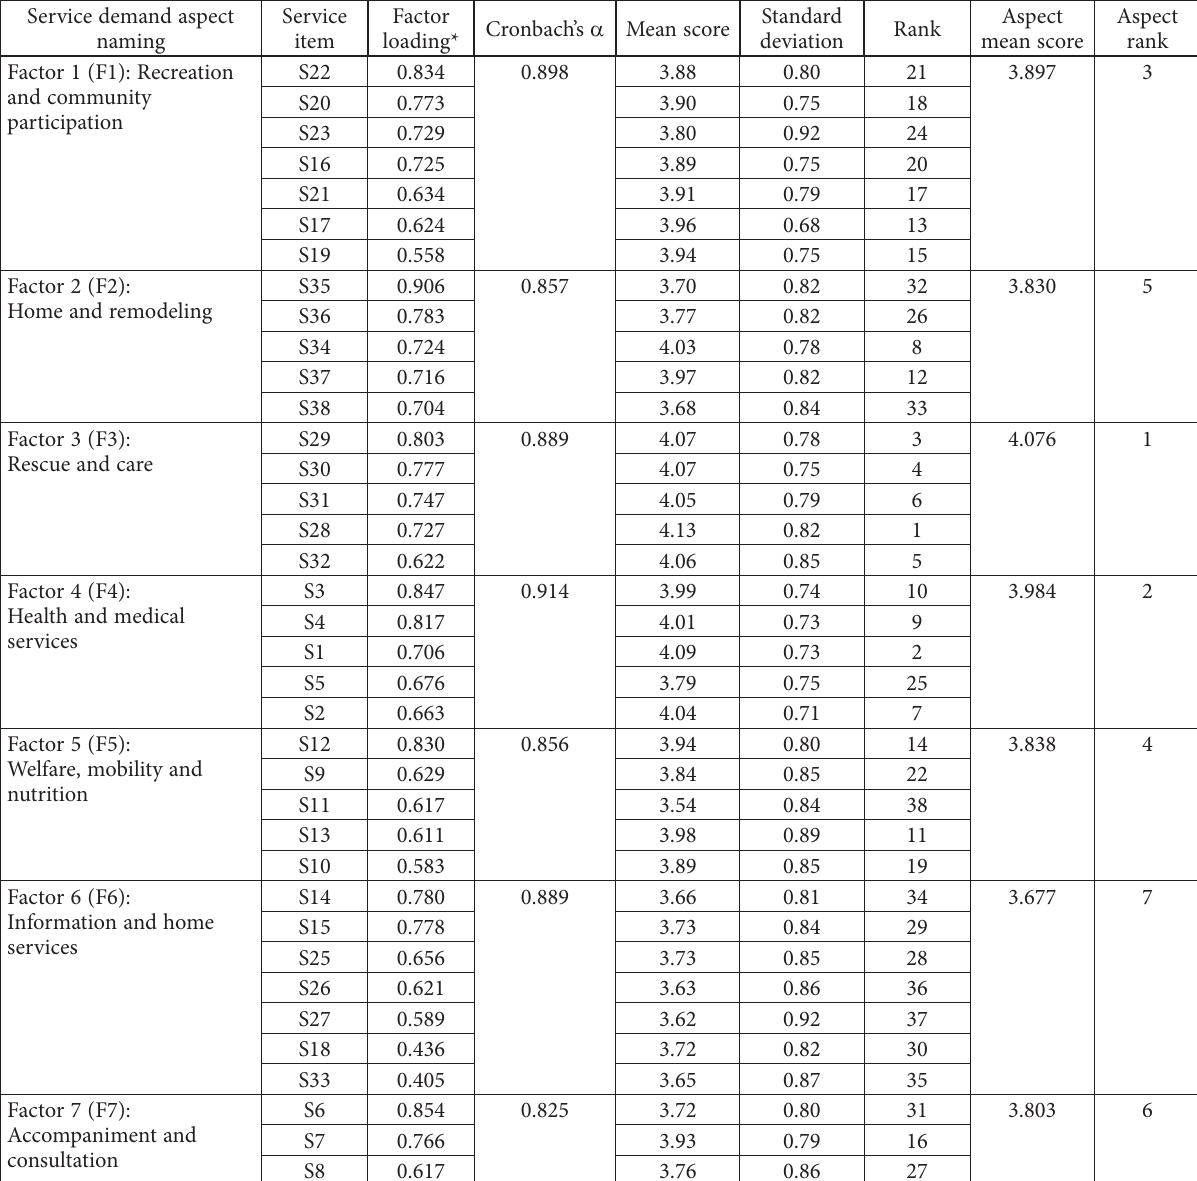
Table 4. Service demand aspects and elderly service demand